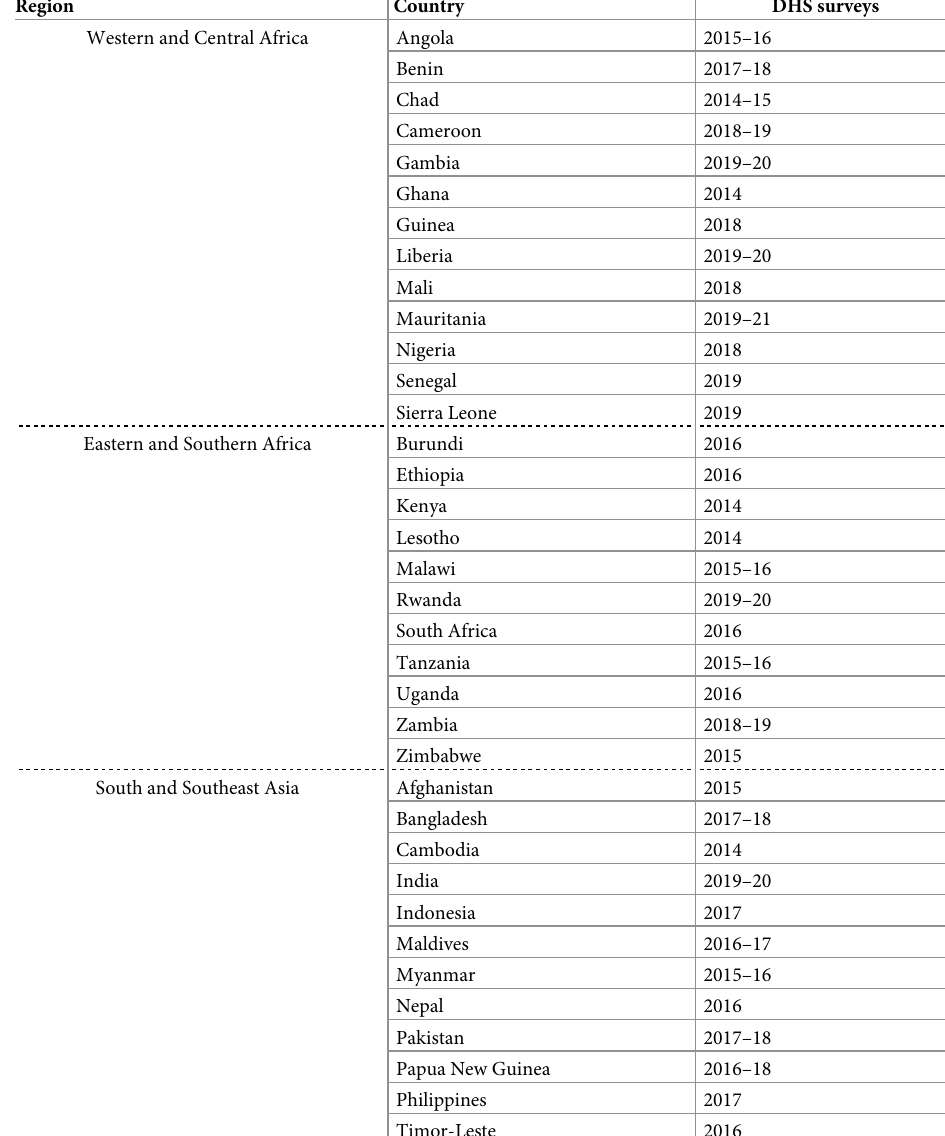
Table 1. Surveys included in the